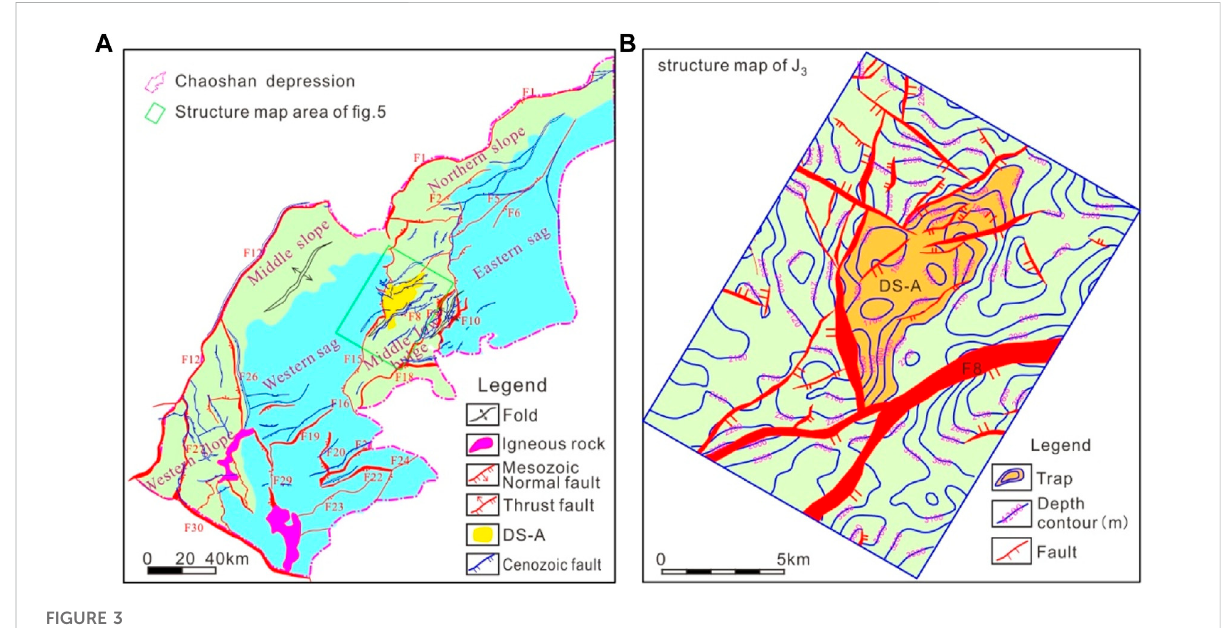
FIGURE 3 Structure map. (A) Chaoshan Depression; (B)